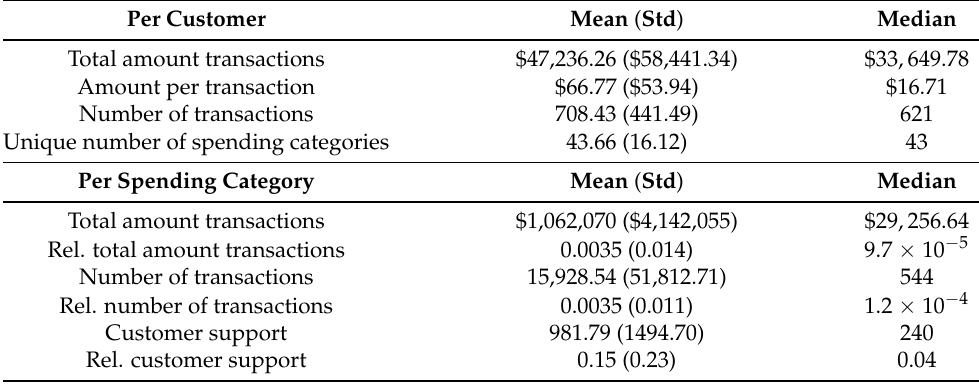
Table 1. Summary statistics of the transactions data. The data contains 4,539,634 spending records between January and December 2019 of 6408 data subjects. Only individuals with at least five transactions and $100 spent in each month, and at least five distinct spending categories are selected. There are 285 spending categories and the average household consists of 3